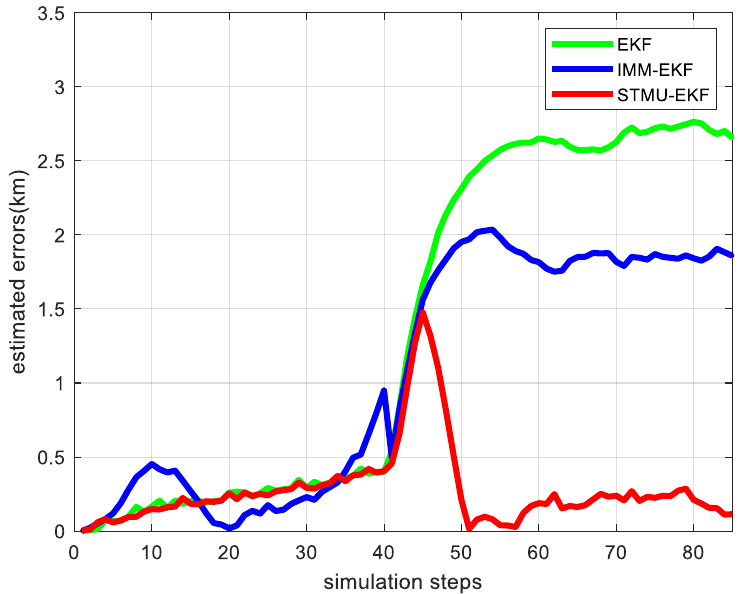
Figure 6. The target tracking error of the three passive target tracking algorithms.